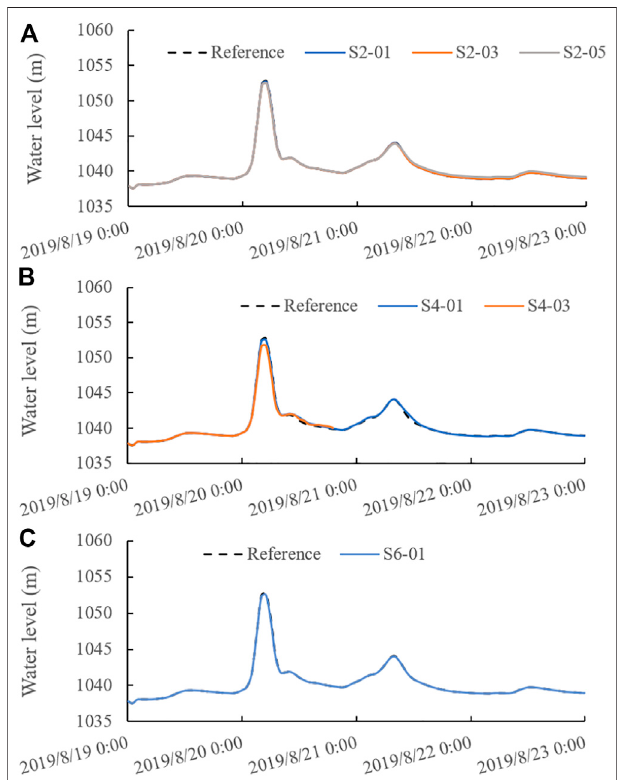
FIGURE 6 | Affected water level at Chainage 9,500 m when sediment in fl ow was from 5,700 m with (A) medium particle size of 0.06 mm with concentration of 1, 3, and 5%; (B) medium particle size of 1 mm with concentration of 1 and 3%. When concentration increased to 5%, river wasclogged,showingnosimulationresults; (C) mediumparticlesizeof3 mm with a concentration of 1%. When concentration increased to 3%, the river was clogged, showing no simulation results.